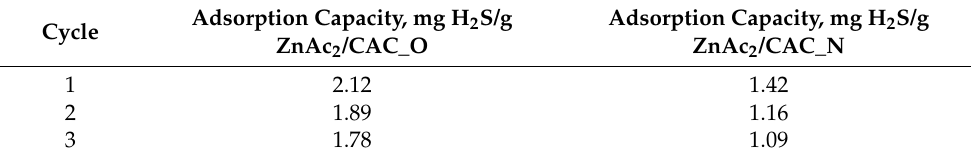
Table 12. Comparison of adsorption capacity in regeneration of adsorption–desorption H 2 S.